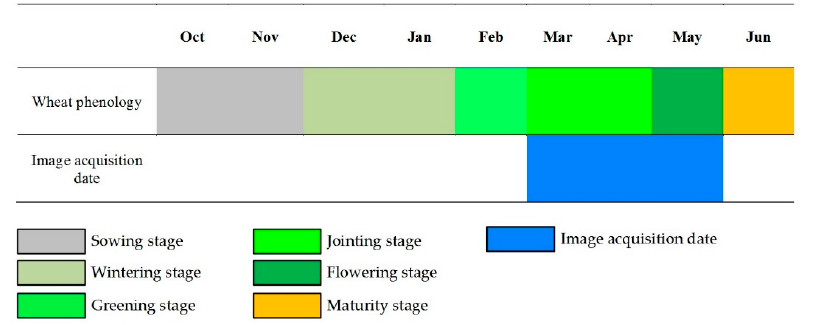
Figure 2. Wheat phenology and image acquisition date.